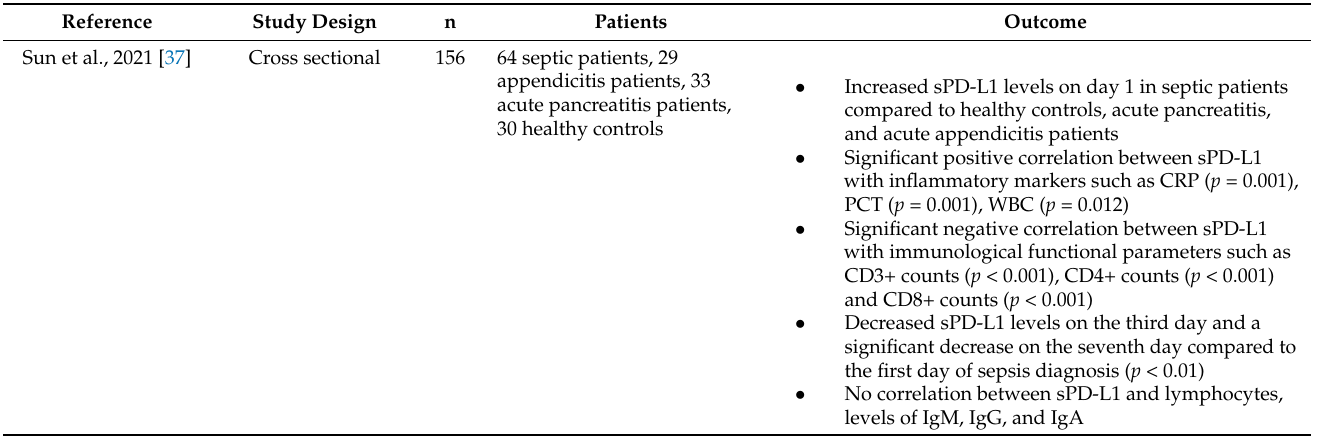
Table 3. Study characteristics of expression level and concentration of PD-L1 protein in septic